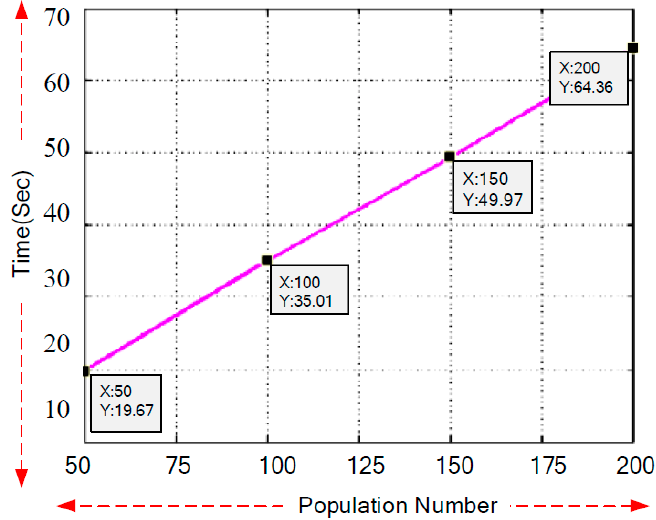
Figure 3. NSGA ‐ II procedure. ( A ) Convergence of the proposed algorithm; ( B ) Step of algo ‐ Figure 3. NSGA-II procedure. ( A ) Convergence of the proposed algorithm; ( B ) Step of algorithm. rithm.